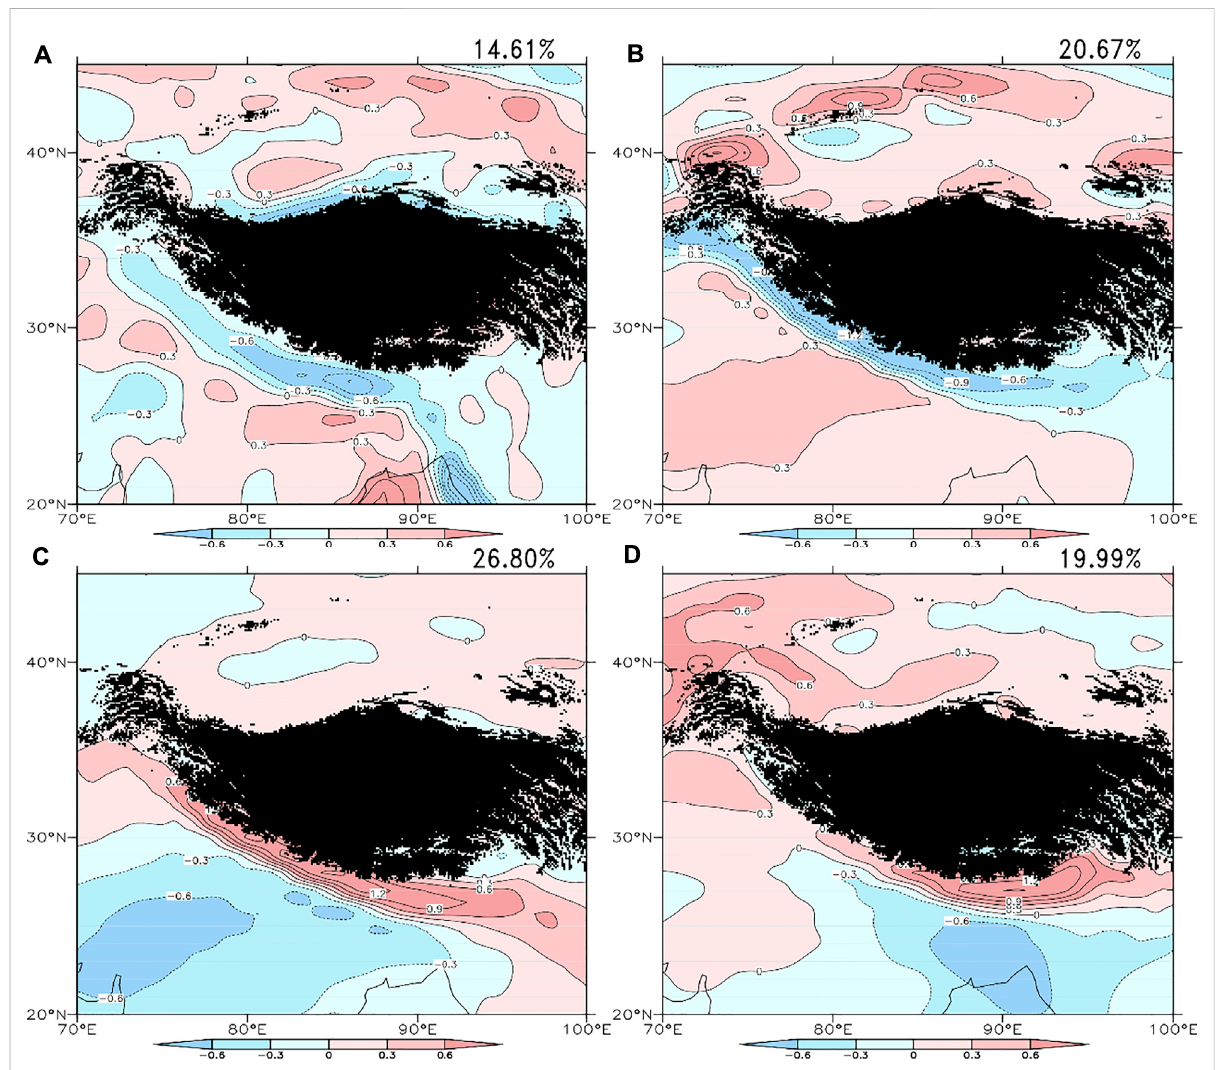
FIGURE 3 Spatial distributions of the fi rst eigenvector of the mean zonal deviation vorticity obtained by the decomposition of the empirical orthogonal function in (A) winter half-year, (B) autumn, (C) winter, (D) spring. The number in the upper right represents the variance contribution of the fi rst eigenvector. Shadow: the